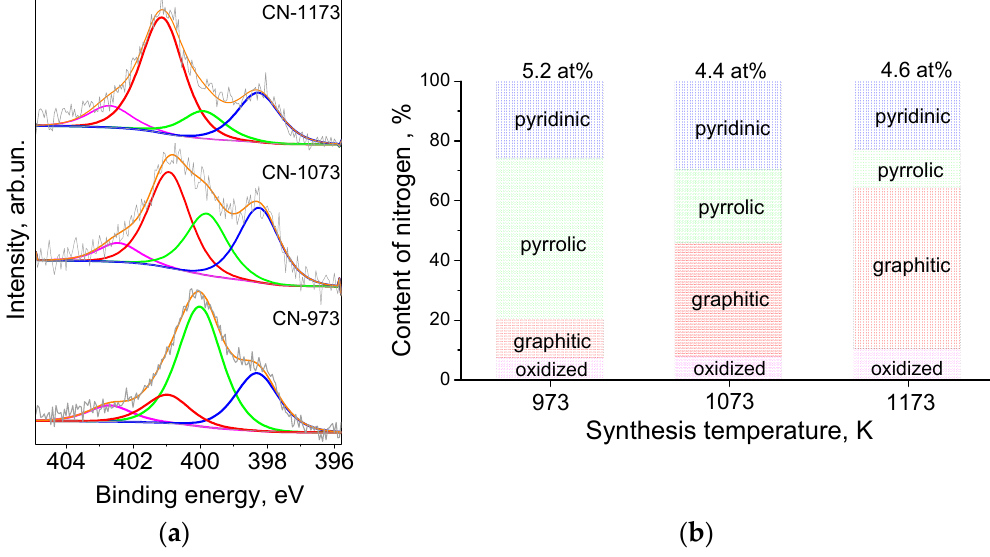
Figure 1. ( a ) N 1s X-ray photoelectron spectroscopy lines for the catalysts supports and ( b ) dependences of the content of nitrogen forms on the synthesis temperature.